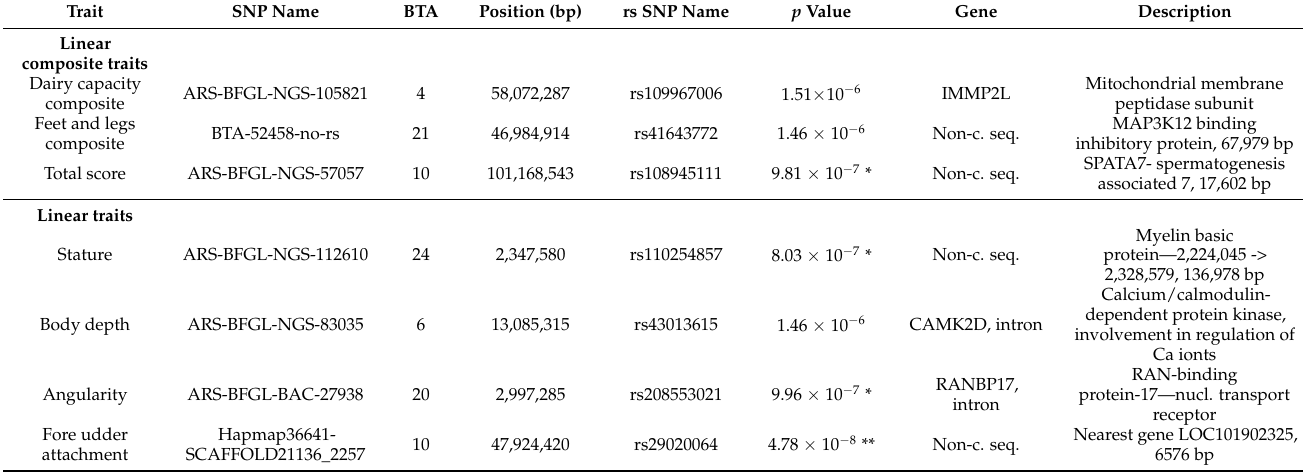
Table 3. The SNP markers with statistically significant (or approaching the significance threshold) associations with linear traits after Bonferroni